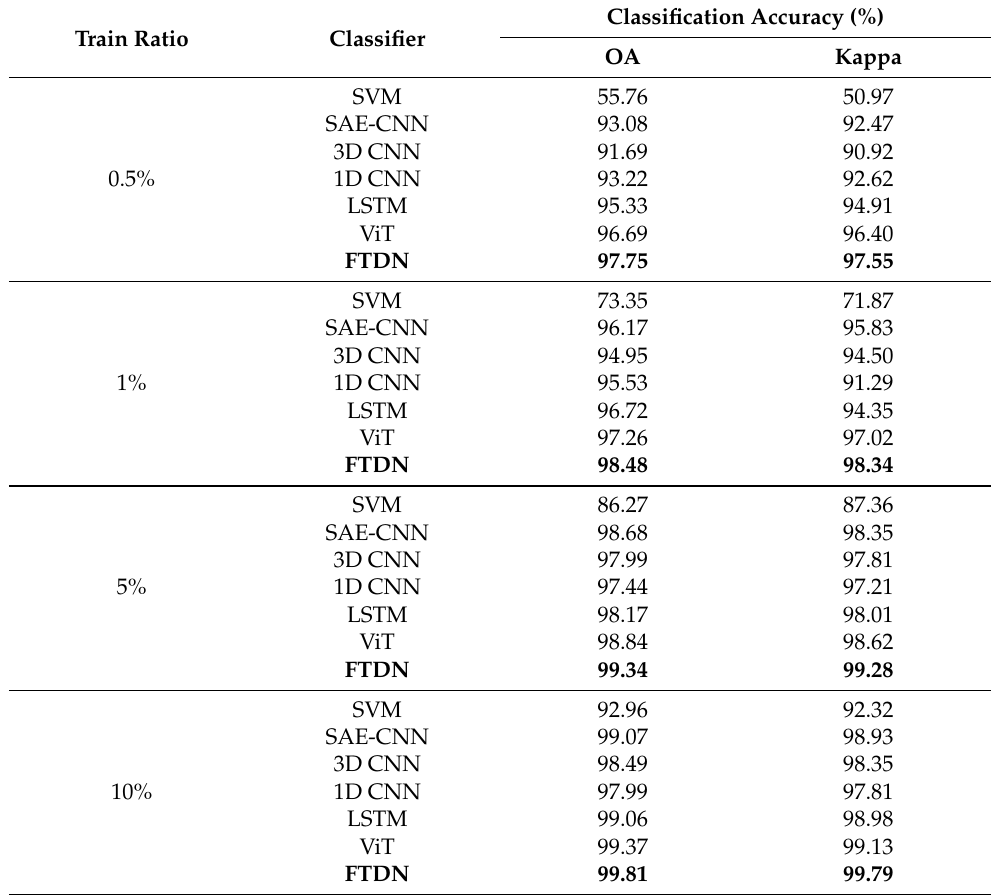
Table 9. Classification performances of different classifiers under different train